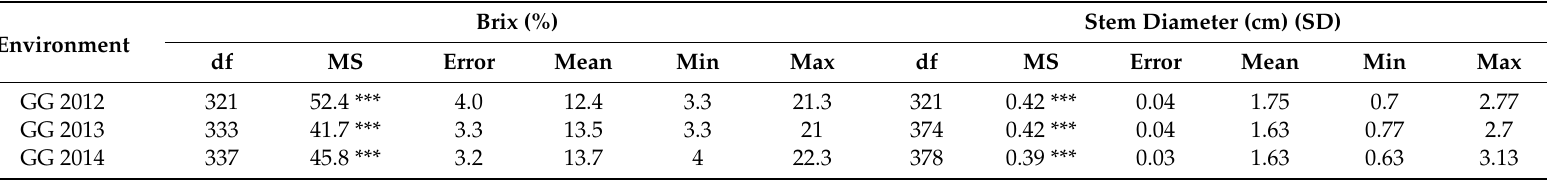
Table 8. Genotypic variances (mean squares, MS) and descriptive statistical traits for brix and stem diameter, separately for the di ff erent environments. Genotypic variances were computed using a general linear model in which genotypes were considered as fixed and replicates as random e ff ects (see Material and Methods). Environment